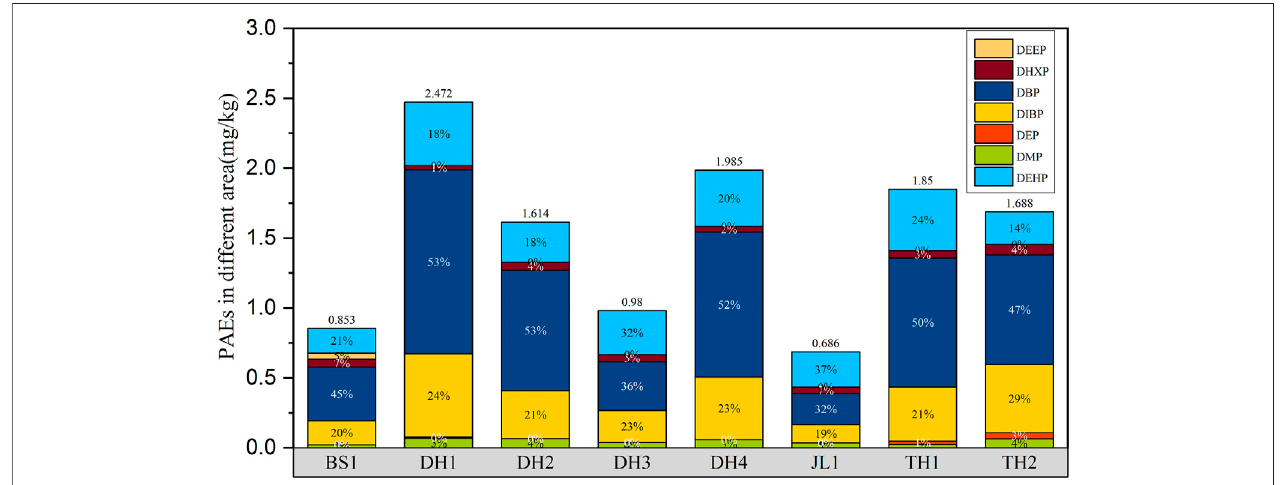
FIGURE 3 | Concentrations and distribution of seven PAEs detected in soils from eight ginseng cultivation bases.